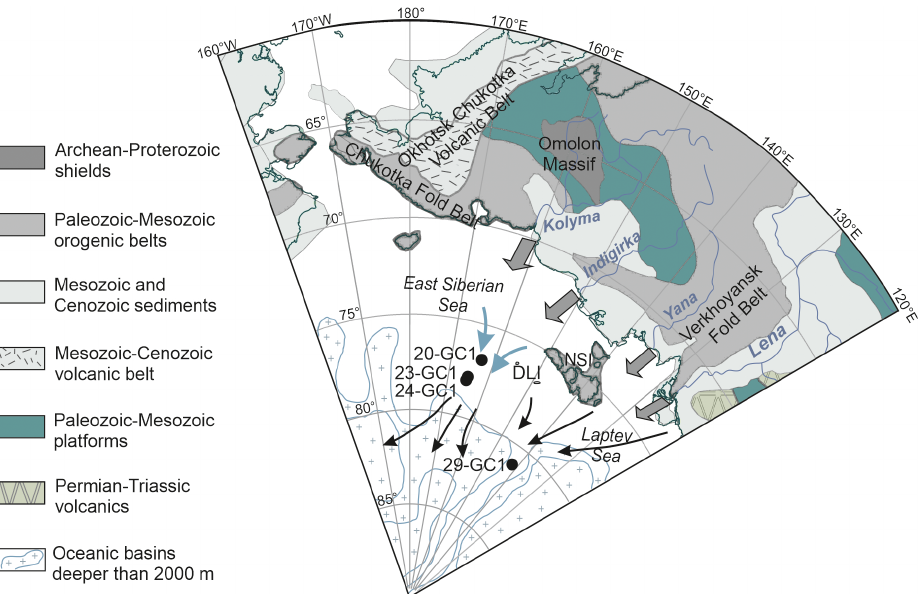
Figure 2. The main geological structures of the probable provenance areas for the studied sediments, adapted after Stein (2008) and Ka- parulina et al. (2016). Grey arrows indicate sediment transport from the rivers, blue arrows show inferred ice flow, and black arrows indicate inferred ice rafting. DLI: De Long Island; NSI: New Siberian Islands.